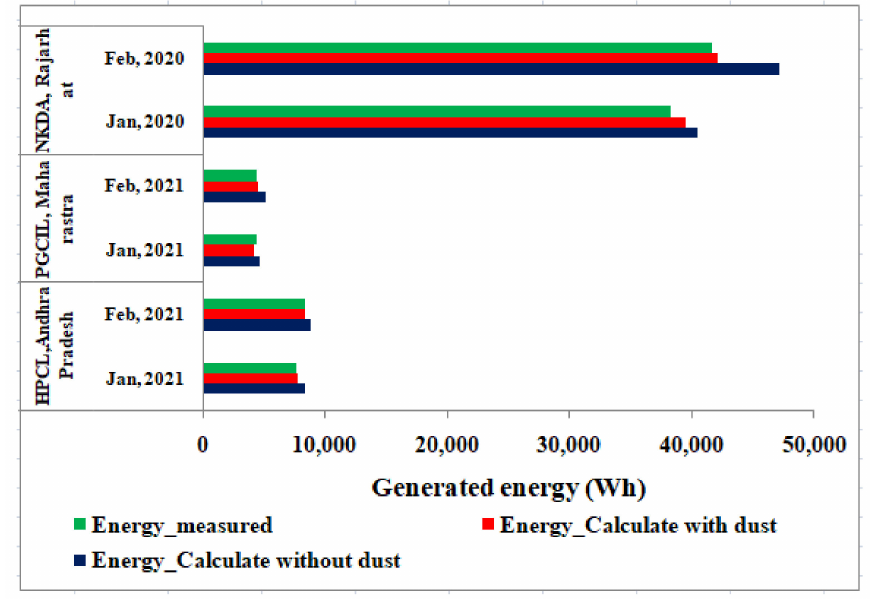
Figure 9. Validation of model for three different locations with different capacities in